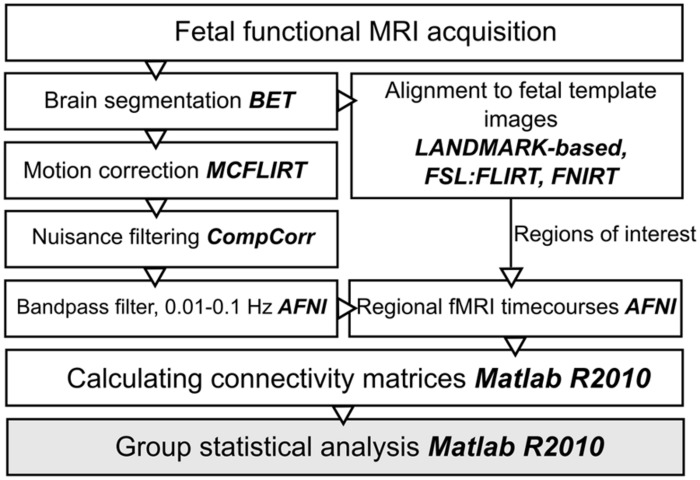
Work diagram of the fMRI processing steps. The names of the respective image processing toolboxes are given in bold. BET, brain extraction tool; FLIRT, FSL linear registration tool; FNIRT, FSL non-linear registration tool; CompCor, component based noise correction method; AFNI, analysis of functional neuroimages.